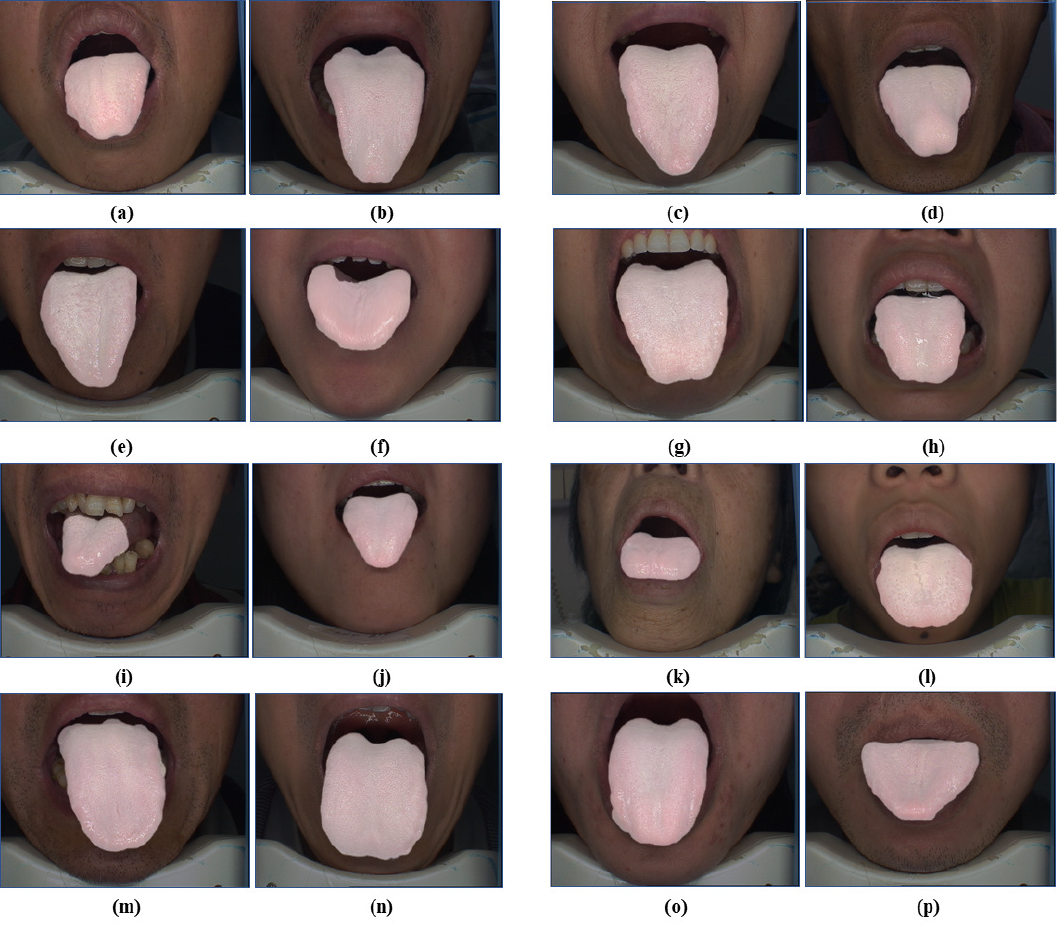
Figure 10. Segmentation results of TongueNet in qualitative evaluation (highlighted). ( a ) and ( b ) results of a tongue with an apparent gap in the mouth; ( c ) and ( d ) results of a tongue with abnormal color; ( e ) and ( f ) results of a tongue with abnormal texture; ( g ) and ( h ) results of a tongue with teeth showing; ( i ) and ( j ) results of a tongue with irregular poses; ( k ) and ( l ) results of a tongue not completely protruding; ( m ) and ( n ) results of a tongue with teeth imprints on the edges; ( o ) and ( p ) results of a tongue closely surrounded by